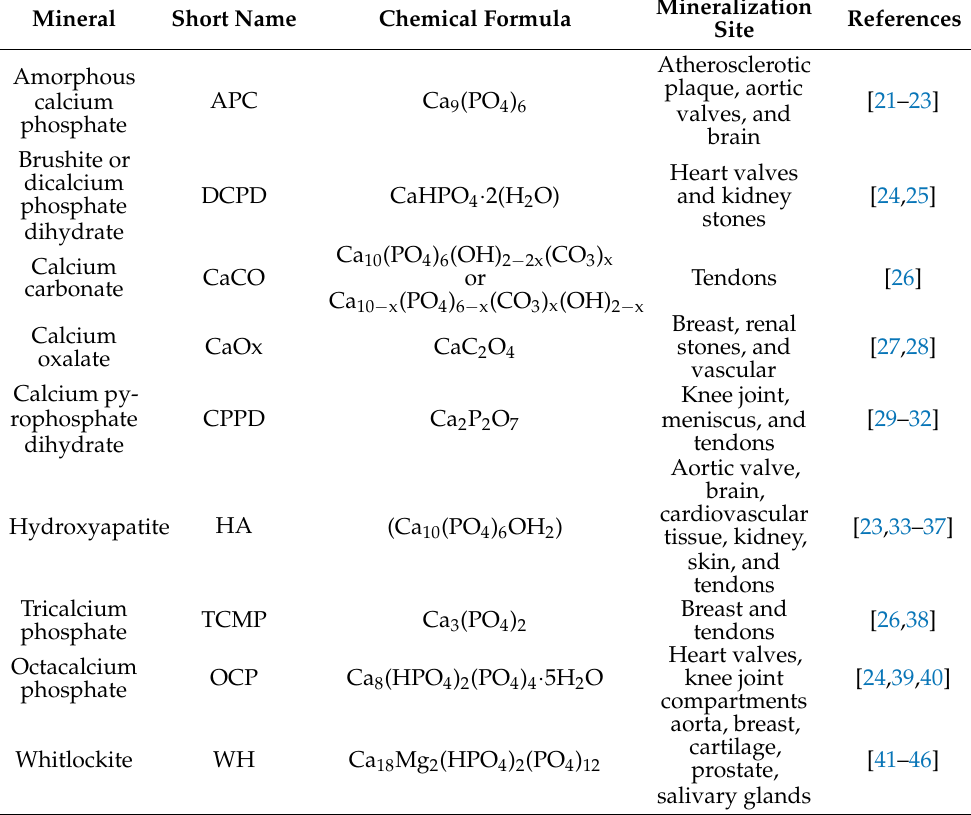
Table 1. Type of crystals found in extraosseous